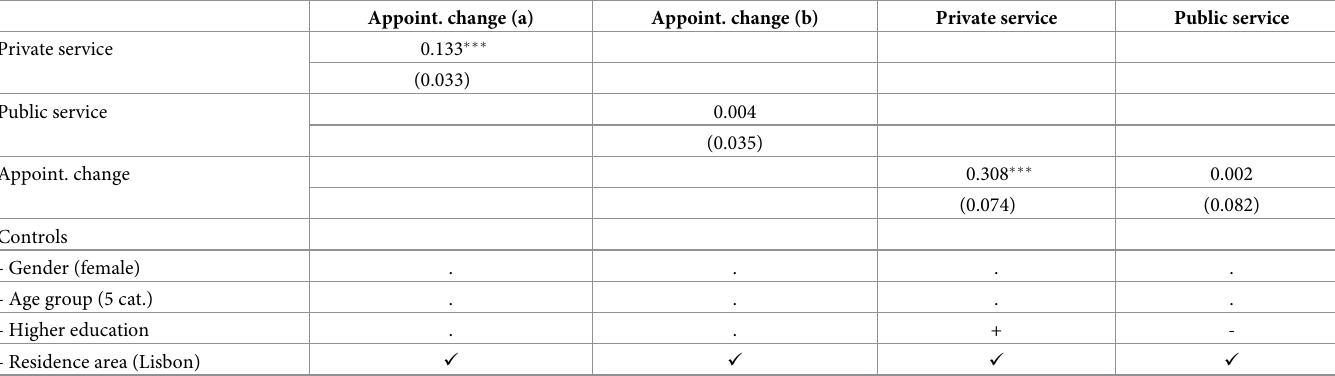
Table 7. Probit (margins) results for health appointment change and type of